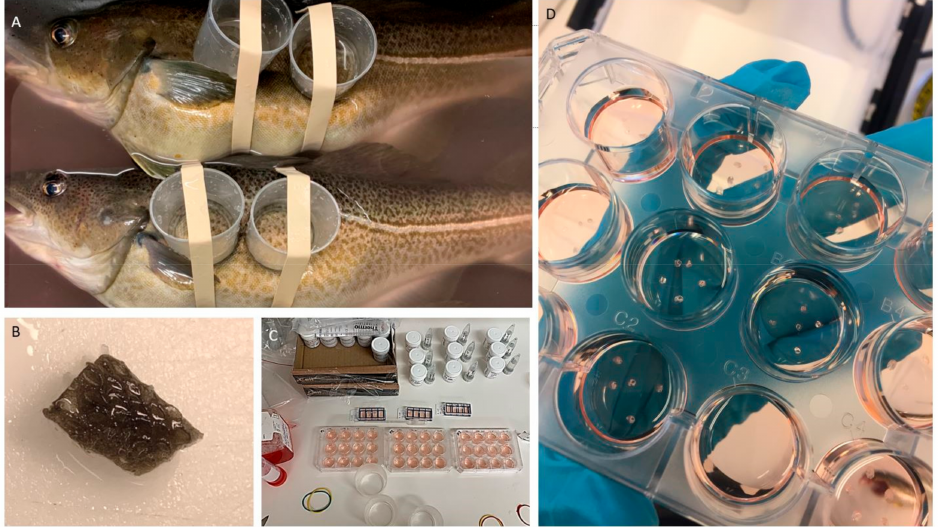
Figure 7. Experimental setup. ( A ) The cup-based system used for exposure studies; ( B ) sampled skin section for histology and SEM, approximately 1 × 0.5 cm; ( C ) plates used for cell cultures; ( D ) five scales were placed in each well to study cell